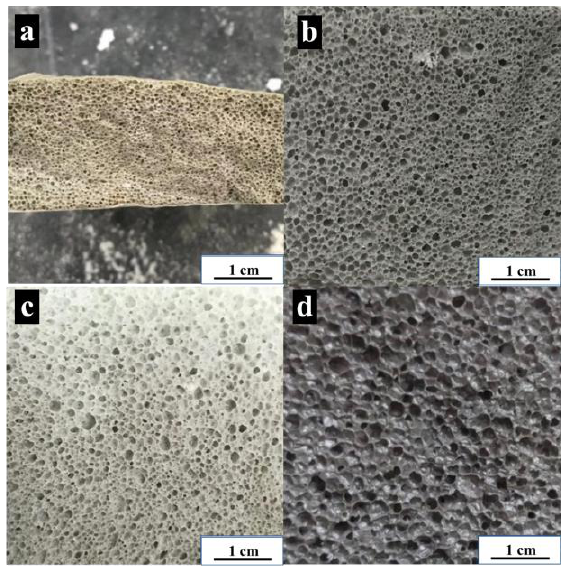
Figure 8. Sectional view of the foam ceramics with different amounts of the foaming agent: ( a ) S5, 0.2%; ( b ) S4, 0.6%; ( c ) S6, 0.9%; and ( d ) S7, 1.2%. 0.2%; ( b ) S4, 0.6%; ( c ) S6, 0.9%; and ( d ) S7,